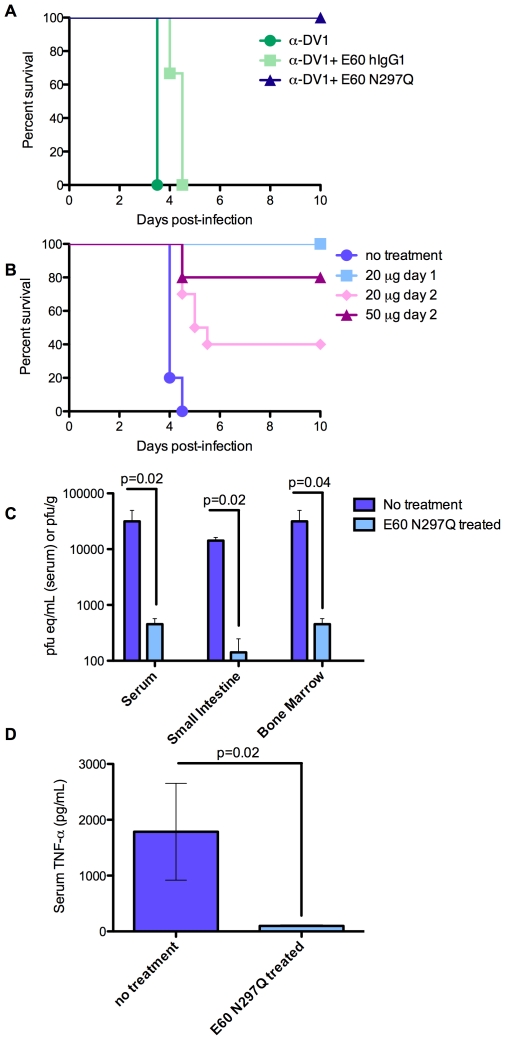
Antibodies with a mutated FcγR binding site have both prophylactic and therapeutic potential and reduce viral load and serum TNF-α in DV-infected mice.
A. Mice were simultaneously administered 25 µl anti-DV1 serum and 20 µg of the indicated E60 mAbs ip, challenged 24 hours later with 2×105 pfu of DV2 iv, and monitored for survival (n = 5 mice per group). p = 0.009 for E60-hIgG1 versus E60-N297Q recipients. B. Mice were administered 25 µl anti-DV1 serum ip, challenged 24 hours later with 105 pfu of DV2 iv, treated by iv administration of E60-N297Q at the indicated doses and days post-infection, and monitored for survival. p-values compared to untreated controls (n = 9) were: p = 0.008 for 20 µg E60-N297Q on day 1 post-infection (n = 5); p = 0.005 for 20 µg E60-N297Q on day 2 post-infection (n = 10); and p = 0.02 for 50 µg E60-N297Q on day 2 post-infection (n = 5). Survival differences were compared using logrank tests. C. Mice were administered 25 µl of anti-DV1 serum ip and infected iv the next day with 105 pfu of DV2. Mice were injected iv with either PBS (untreated) or 20 µg E60-N297Q 24 hours later. On day 3.5 p.i, mice were euthanized and serum and tissues were collected. Viral burden in serum, small intestine, and bone marrow were measured by qRT-PCR for serum and plaque assay for solid tissues. D. Serum TNF-α was measured by ELISA. n = 4 mice per group in all analyses. For viral load and TNF-α values, error bars represent standard deviations, and pairwise comparisons were performed by two-sided Wilcoxon rank sum tests.